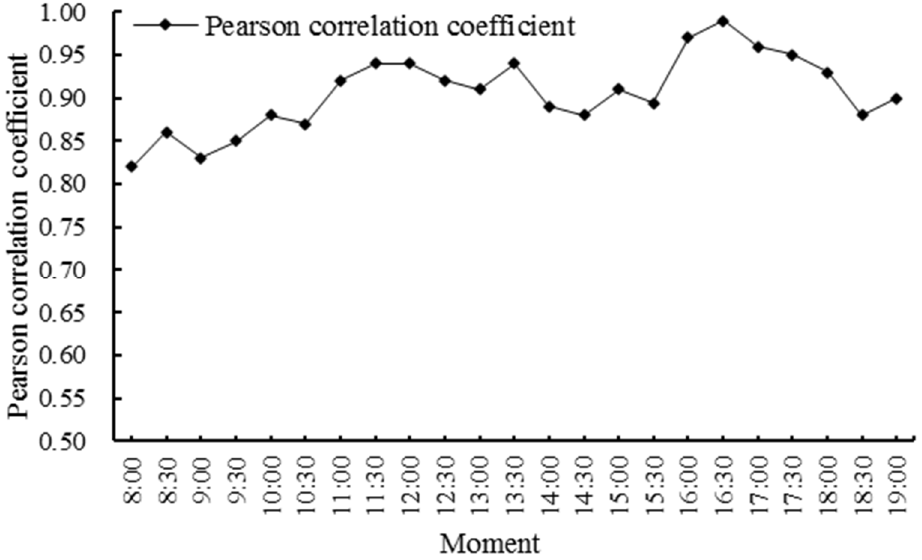
Figure 8. Changes in the Pearson correlation coefficient between the number of evacuation guiders and the number of evacuees at different moments on 5 May 2021.